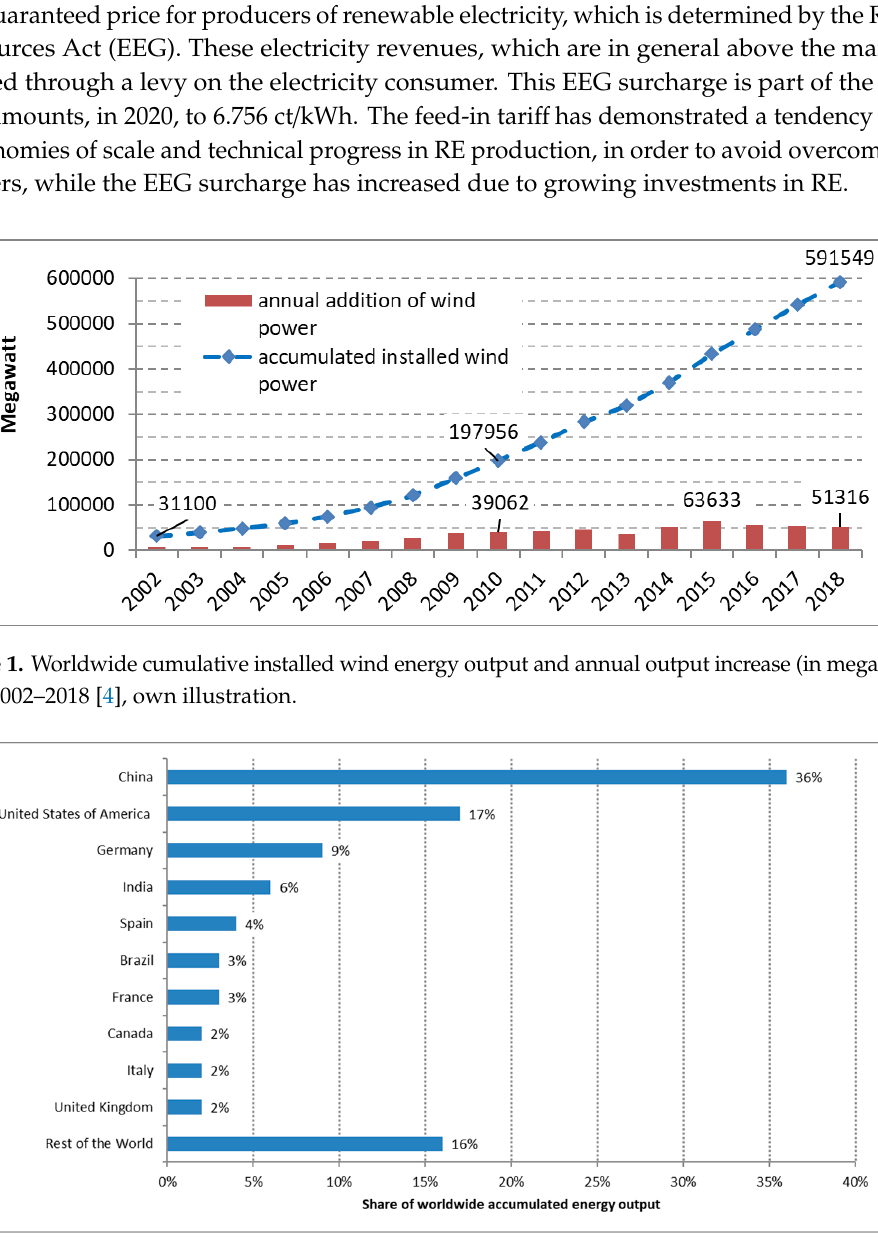
Figure 2. Most important countries by share of the worldwide installed onshore wind energy output (cumulative) in 2018 [4].